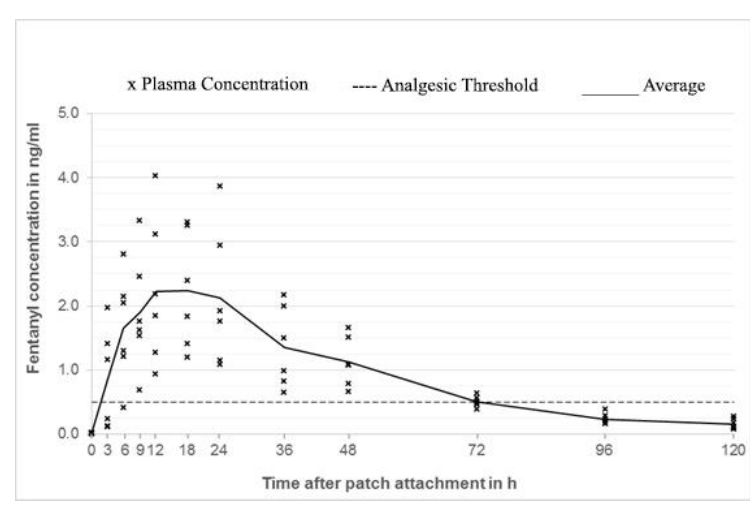
Figure 2. Fentanyl plasma concentrations group 1 (outer surface of the ear).